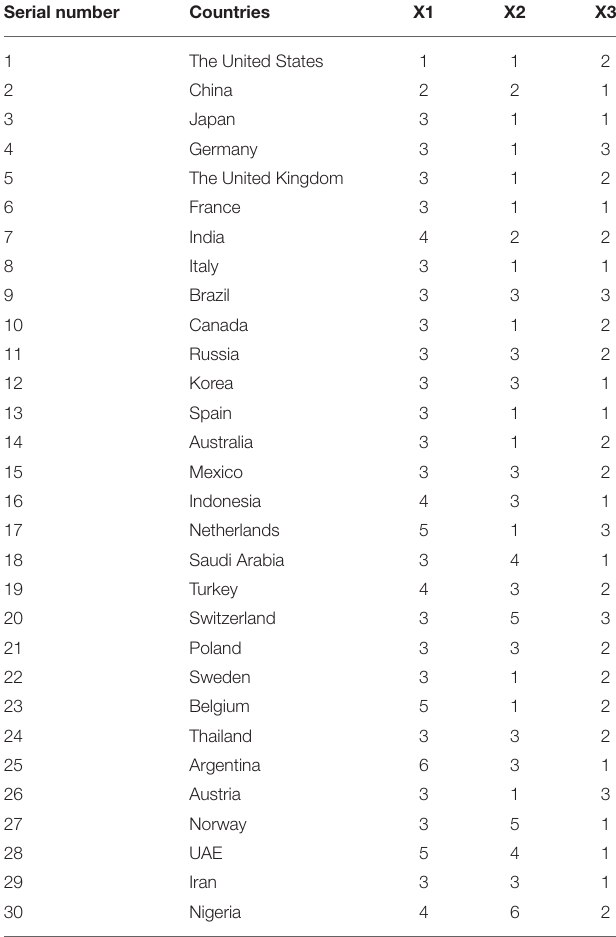
TABLE 1 | Selected indices for cluster analysis. Primary clustering